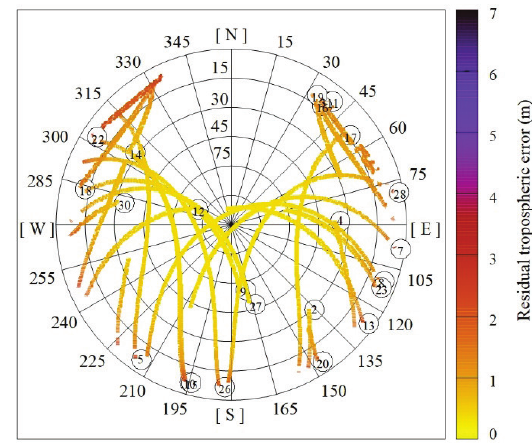
Figure 9. Simulation of the residual tropospheric error in meters (GBAS mode). Altitude difference 1000 m